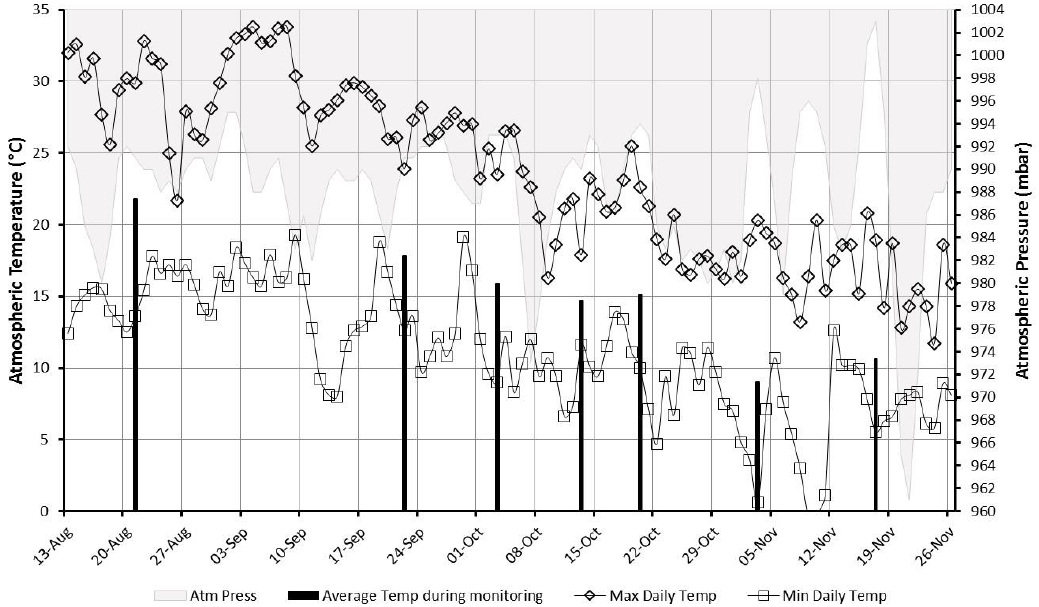
Figure 1. Atmospheric temperature and pressure at Casa Rota Landfill during the monitoring.